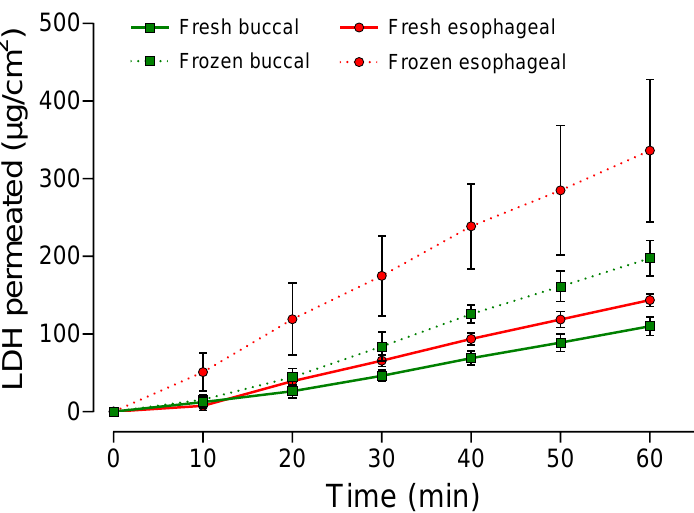
Figure 5. Profiles (mean ± SD, n = 9–10) for the permeation of lidocaine hydrochloride (LDH) during 1 h across fresh and frozen swine esophageal and buccal mucosas, for the formulation applied under infinite dose conditions. Linear regression analysis between curves: fresh buccal × esophageal ( p = 0.0008); frozen buccal × esophageal ( p < 0.0001); fresh buccal × frozen buccal ( p < 0.0001); fresh esophageal × frozen esophageal ( p < 0.0001).